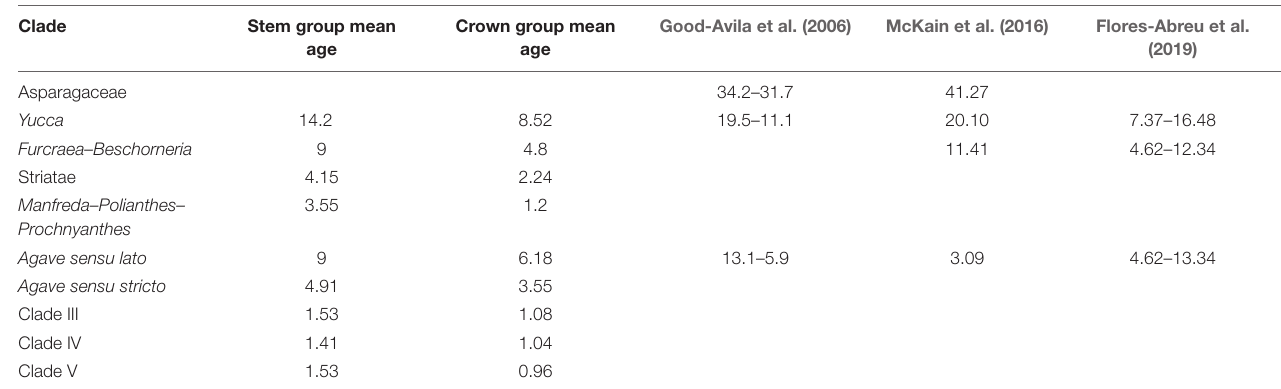
TABLE 3 | Age estimation in million years of major divergence events and compared with those found in other studies. Clade Stem group mean